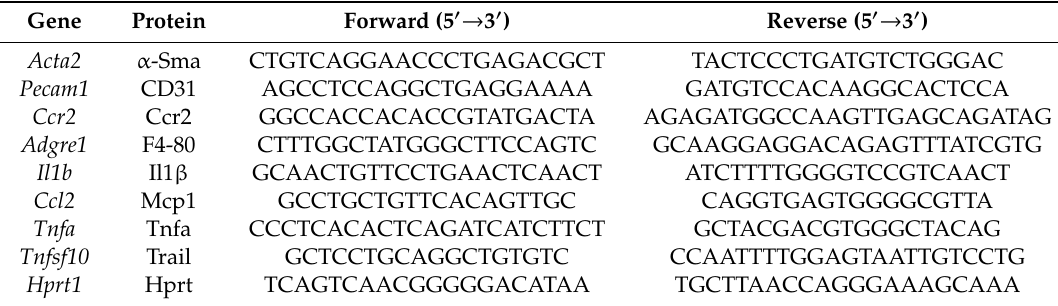
Table 2. Mouse primer used for quantitative real-time